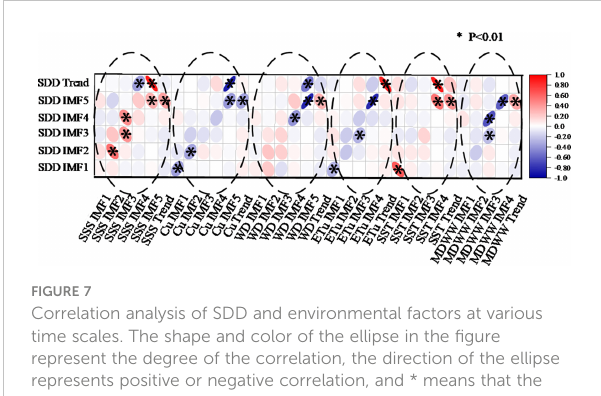
FIGURE 7 Correlation analysis of SDD and environmental factors at various time scales. The shape and color of the ellipse in the fi gure represent the degree of the correlation, the direction of the ellipse represents positive or negative correlation, and * means that the data has been tested for signi fi cance at